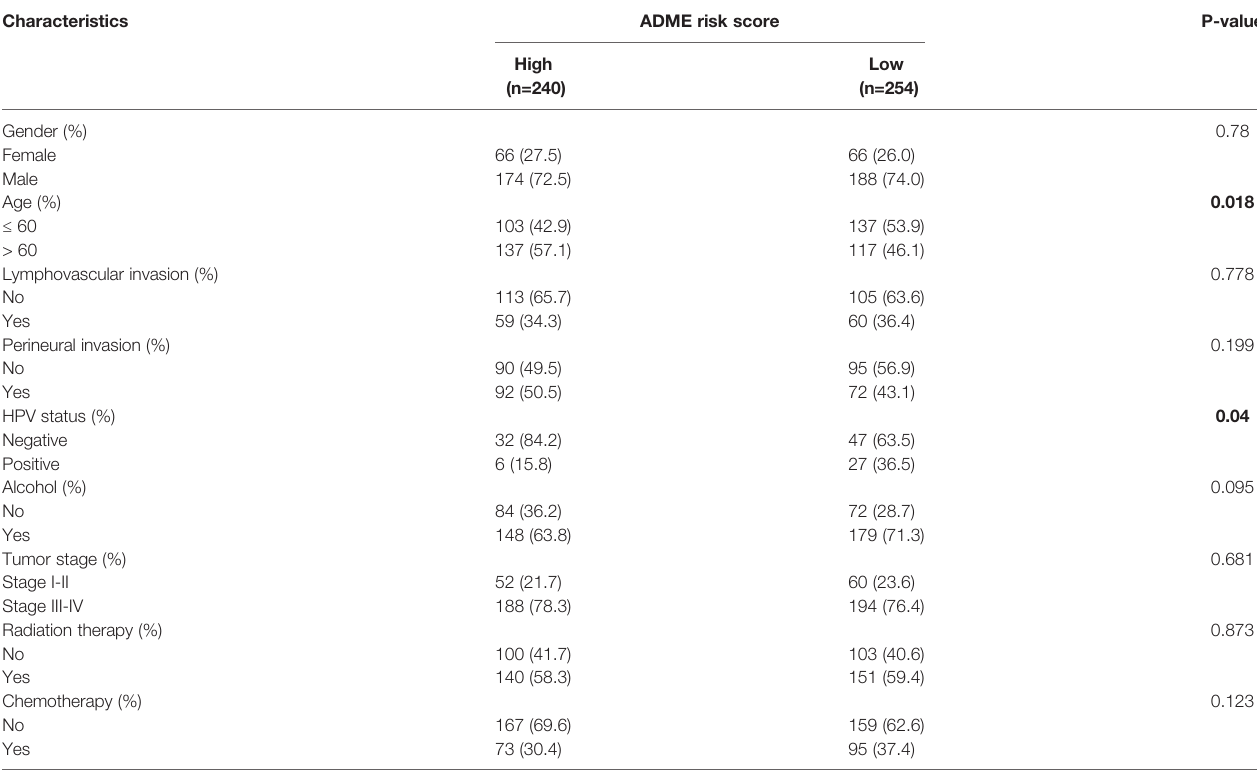
TABLE 1 | Clinical characteristics of the patients strati fi ed by low and high expression of ADME risk score in TCGA-HNSC cohort. Characteristics